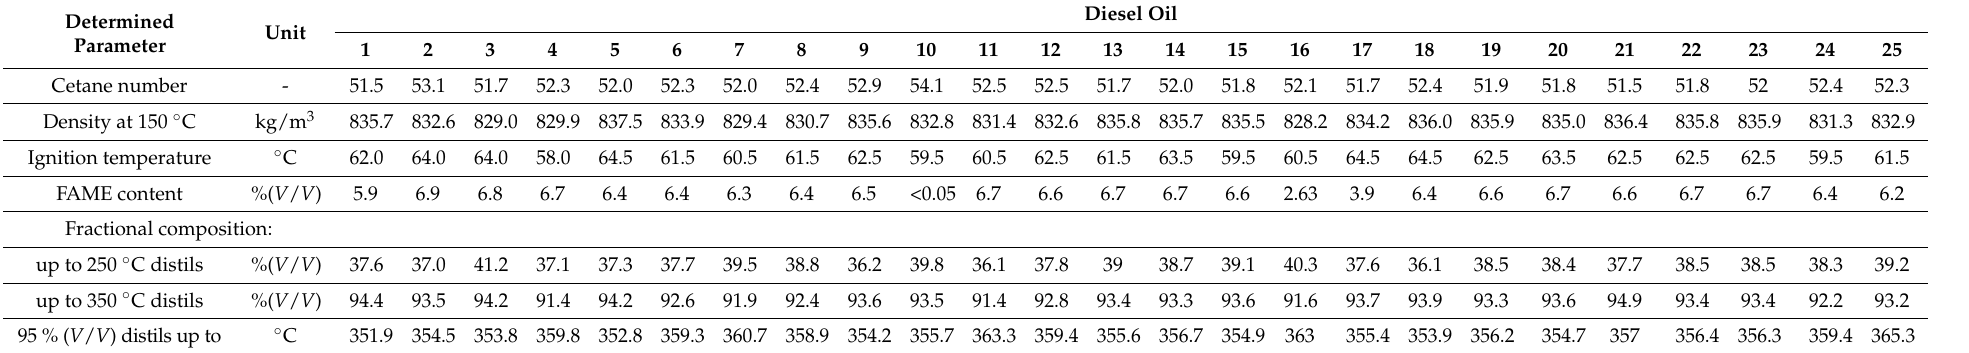
Table 1. Properties of the studied diesel oils (measured by